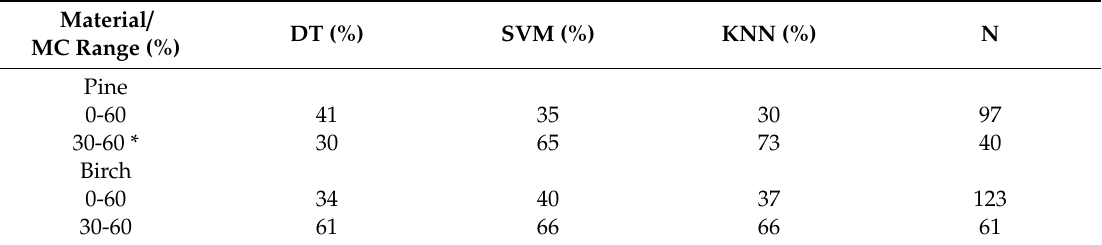
Table 4. Classification results, correct classification (%). Pine heartwood / sapwood and birch bark / wood, 5 classes: 0, 25%, 50%, 75% and 100% mix ratios. Classification by using decision tree (DT), support vector machine (SVM) and K-nearest neighbor (KNN). N = number of